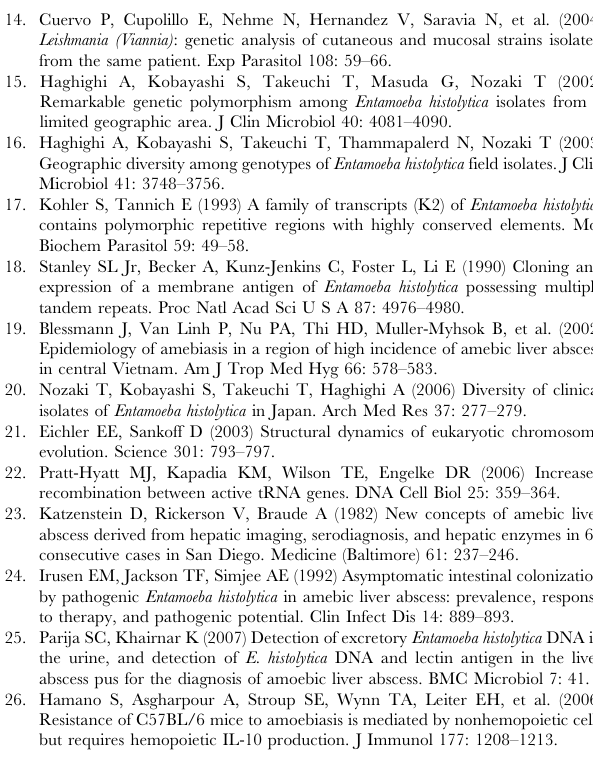
Figure S2 Sequencing traces indicating the presence of alternative sequence variants. A. Reverse complement of locus S TGA -D from the stool DNA of the Italian amebic liver abscess patient. The sequence in black text under the trace is that of the minor peaks that can be seen, and is consistent with a variant that is shorter by one STR. B. Reverse complement of locus S TGA -D from the liver abscess of the Italian patient. The sequence in black text under the trace is that of a minor product and is consistent with a variant that is longer by one 9 base STR. C. Traces showing effect of indel. The upper traces is the sequence of locus R-R from the stool DNA and the lower trace that from the ALA DNA of BAN-14. The location of the indel is indicated by the 6T/ 7T notation and the box highlights the identity of the minor peaks in the upper trace with the sequence of the lower trace. The arrows indicate the position of the transversion that differentiates the two sequences (also seen in Figure S1). Figure S3 PCR product size polymorphism in paired